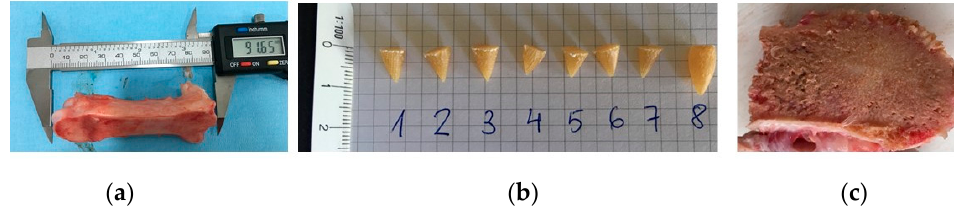
Figure 6. Penetration assay in the bone: ( a ) pork bone used; ( b ) skewer geometry; ( c ) section of the cancellous bone where the skewers will be inserted.